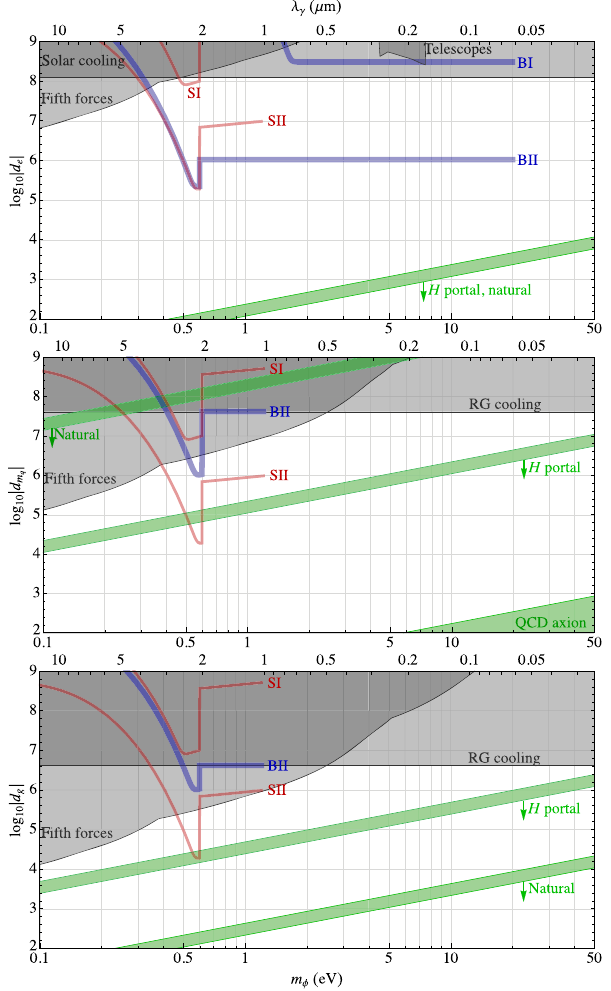
FIG. 11. Reach for scalar dark matter couplings to photons ( d ), e light quarks ( d ˆ ), and gluons ( d ) as a function of scalar mass. m q g Labels are as in Fig. 10, except the cooling bound on d comes e from cooling processes in the Sun rather than red giants, and we also show constraints from telescope searches for scalar decays into two photons in the same plot. In addition, we indicate the experimentally allowed region for the scalar coupling d ˆ of the m q QCD